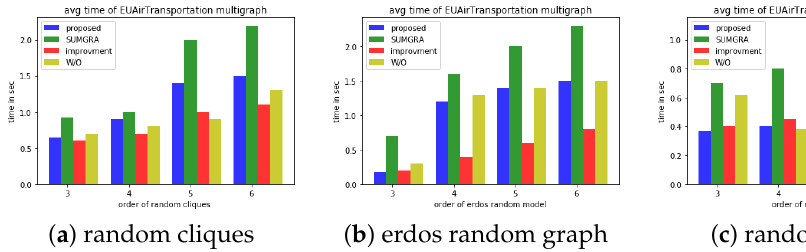
Figure 12. Query time on EUAi dataset.